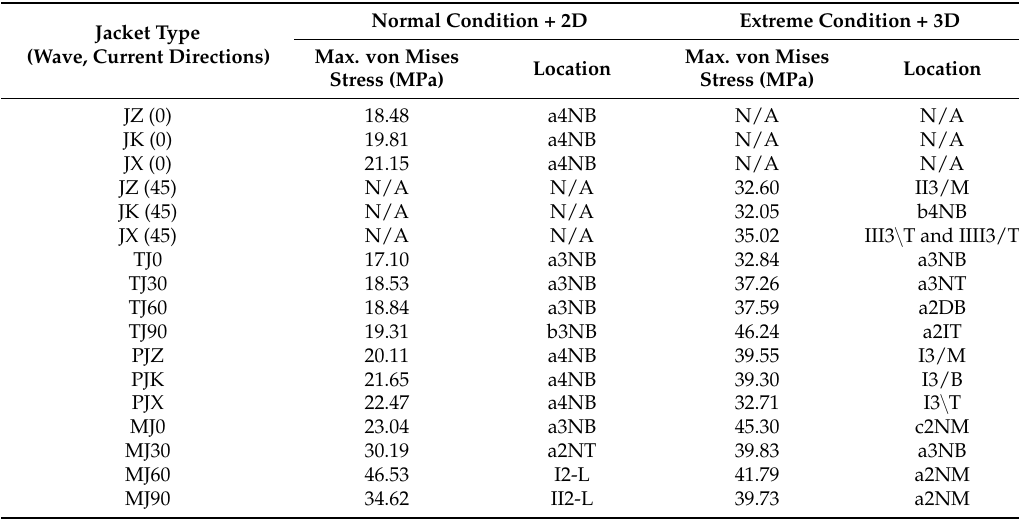
Table 2. List of maximum von Mises stresses for 14 substructures under various load settings (denoted (0) and denoted (45)) represent the principal and diagonal directions, respectively).